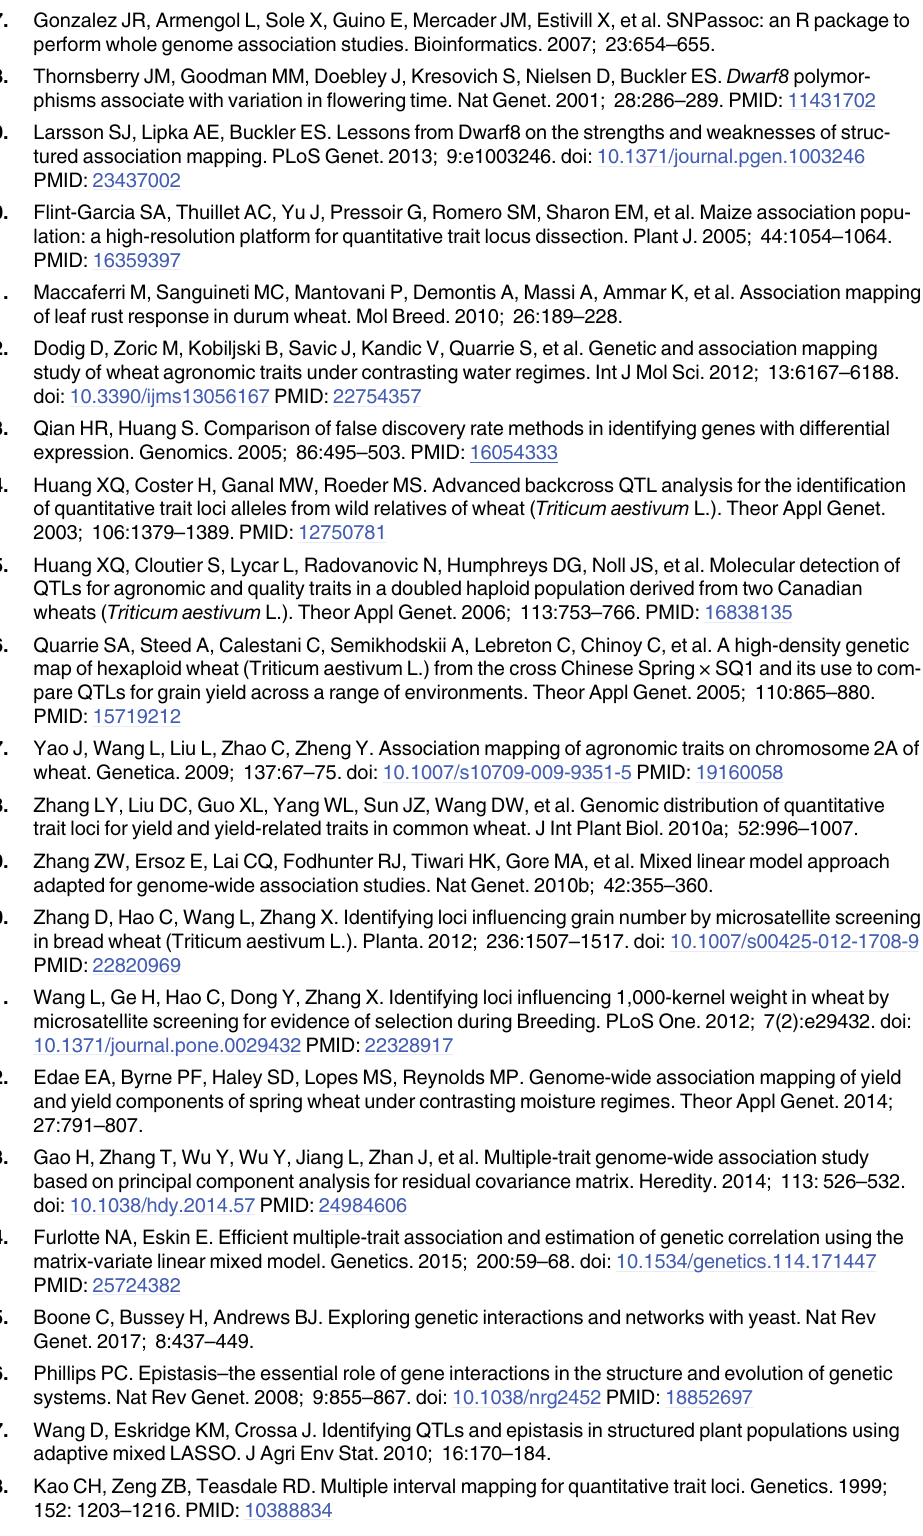
PLOS ONE | DOI:10.1371/journal.pone.0159343 July 21,